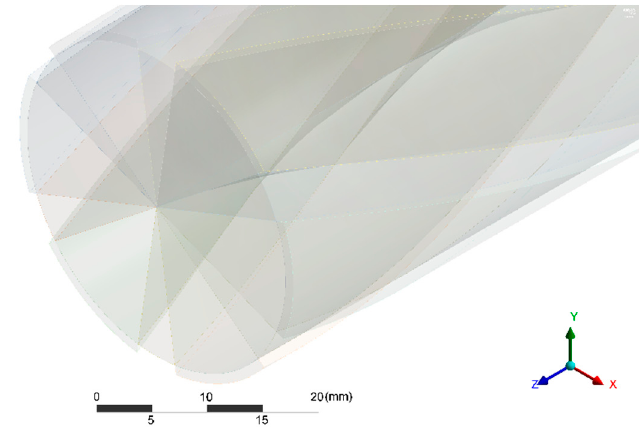
Figure 10. Distribution of the heat transfer coefficient on the rifled tube inner surface. The pressure losses due to friction were modelled using the model presented in Figure 11 and the mesh shown in Figure 12.